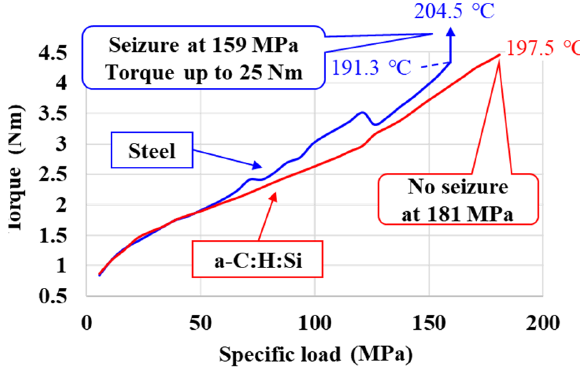
Table 8. Specific load at conclusion of seizure test.